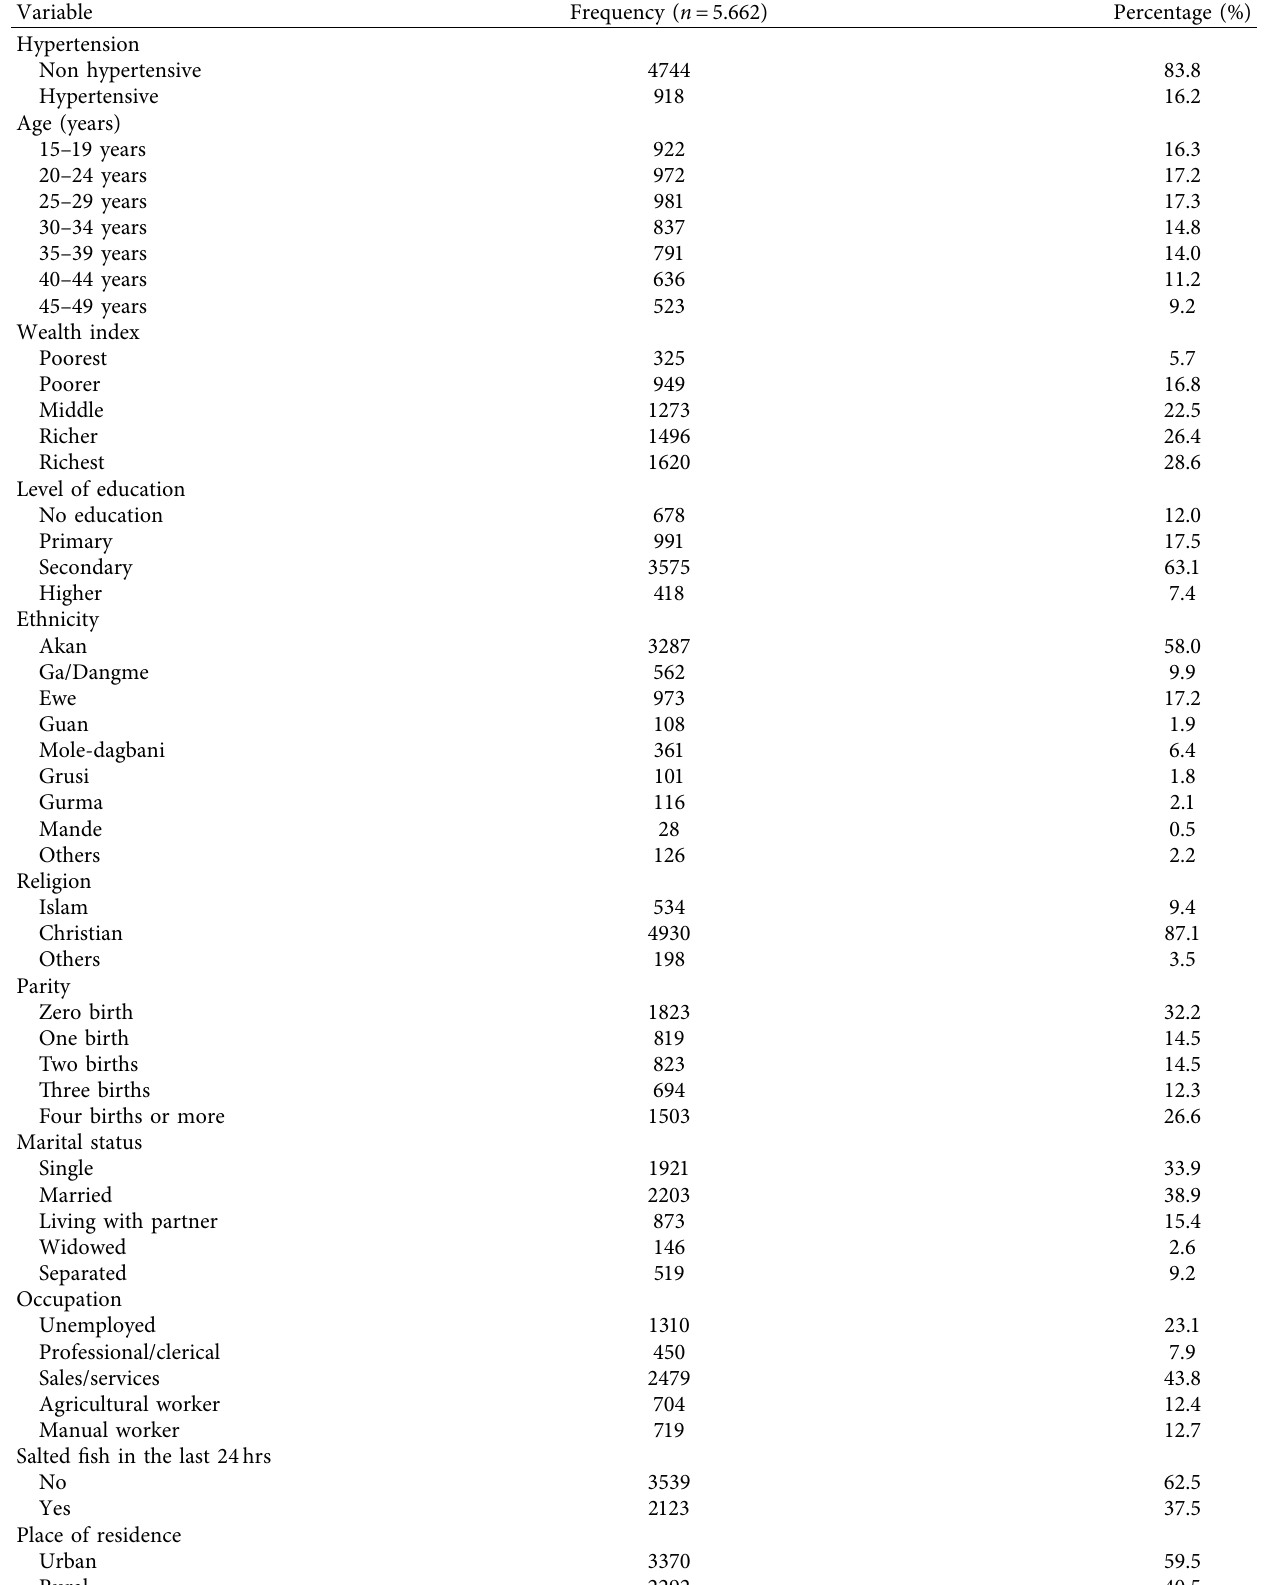
Table 1: Background characteristics of